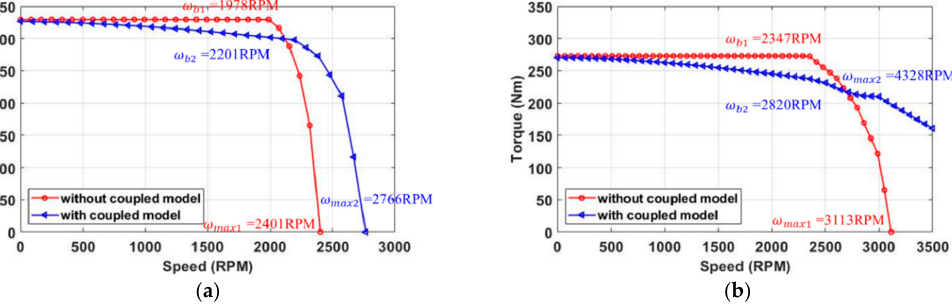
Figure 10. Torque speed curves of ( a ) the modular machine and ( b ) the non-modular machine with or without considering the EM–thermal coupling.